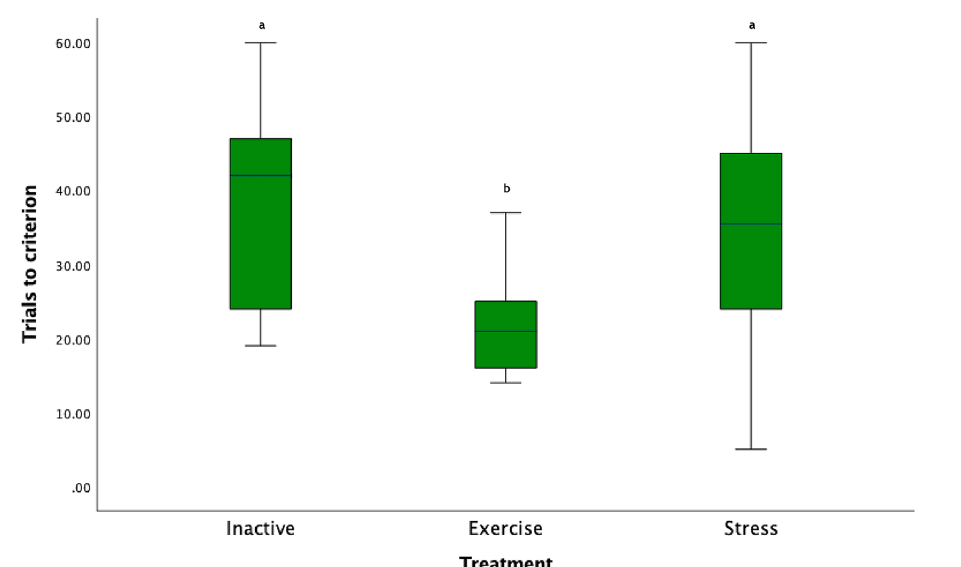
Figure 2. Box plot of number of trials to reach the learning criterion: Key: Letters that differ are significantly different at p <